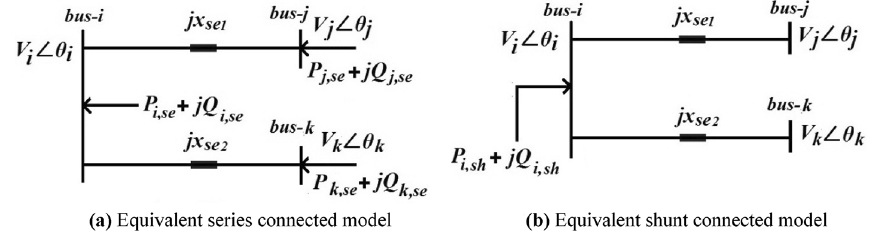
Fig. 3 a Equivalent series connected model, b equivalent shunt connected